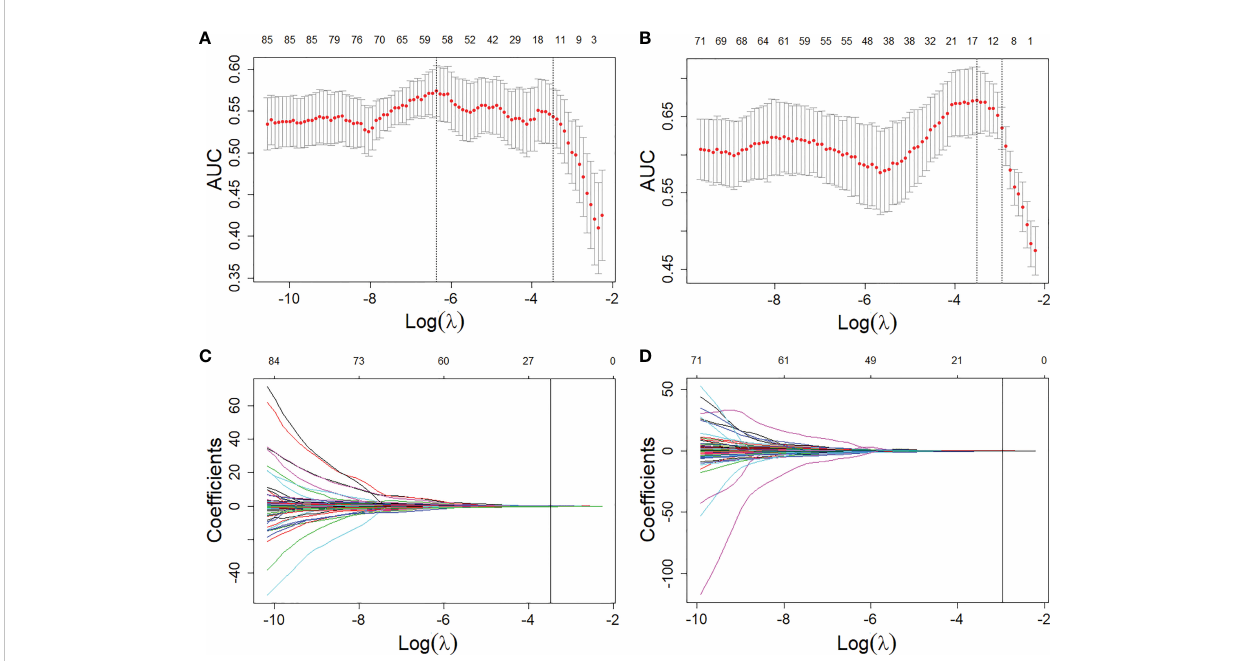
FIGURE 3 Feature selections from the T1W and T2FS MRI with LASSO. (A, B) , LASSO coef fi cient analyses of the features with 5-fold cross-validation for selecting optimal log ( l ) in T1W (A) and T2FS (B) MRI, respectively. (C, D) , LASSO coef fi cients plotted against the log ( l ) sequence in T1W (C) and T2FS (D) MRI, respectively.